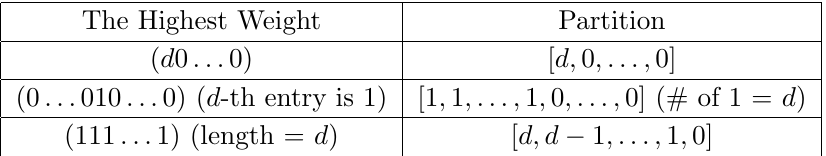
Table 3. Examples of the bijection between the highest weight and the